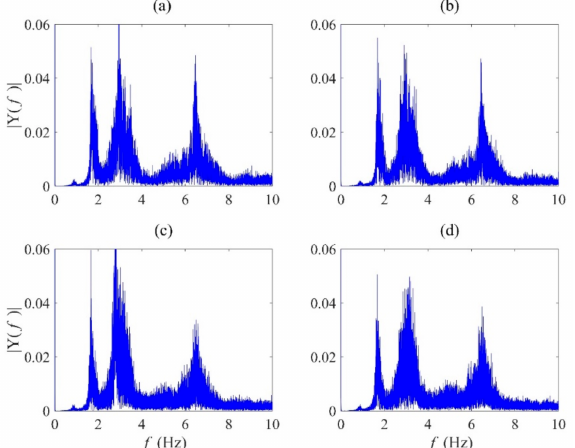
Figure 6. Fourier spectra of the middle sensor of the Eeklo Pedestrian Bridge obtained from test #: